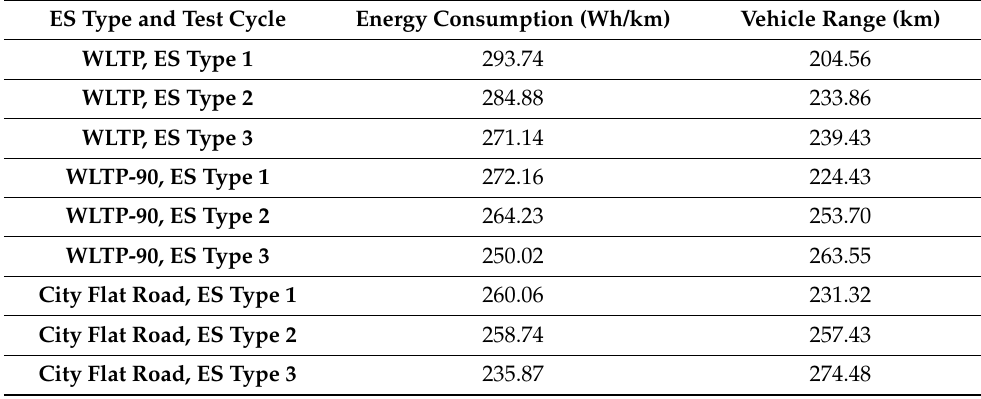
Table 5. Vehicle energy consumption and range, at 0 ◦ C ambient temperature.